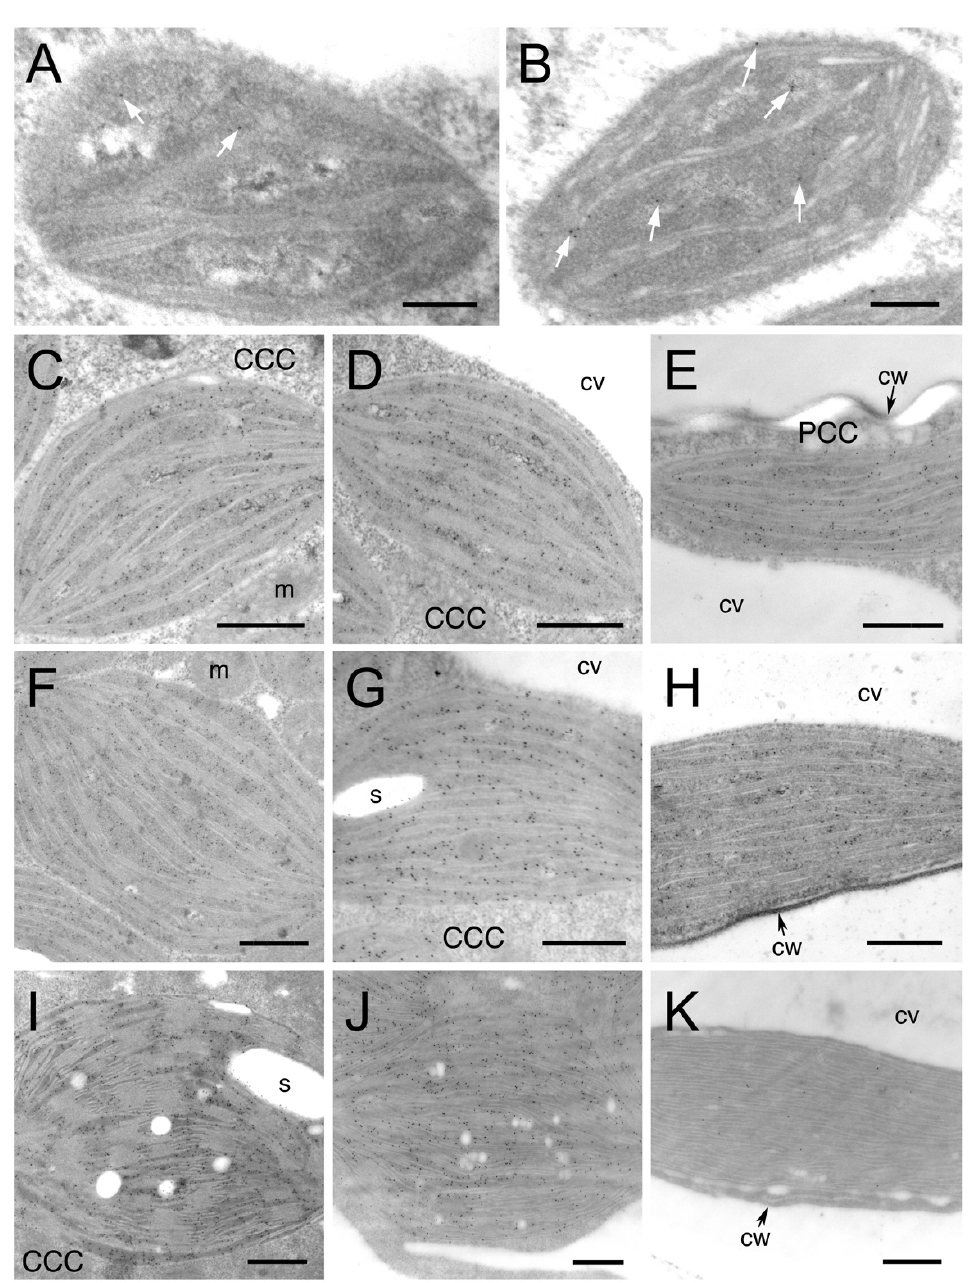
Figure 2. Immunolocalization of RbcL in chloroplasts in developing leaves of B. sinuspersici . Leaf cross-sections from various developmental stages were probed with RbcL antiserum and then with a gold-conjugated secondary antibody. Images are transmission electron micrographs of chloroplasts in ( A ) youngest, ( B ) young, ( C – E ) intermediate, ( F – H ) premature, and ( I – K ) mature leaves showing a specific reaction of the RbcL antibody. Starting from the intermediate stage, the CCC and PCC ( E , H , K ) are evident. Chloroplasts in the CCC were further divided into the inner layer of CCC (CCCI: C , F , I ) and the outer layer of CCC (CCCO: D , G , J ). White arrows indicate gold particles ( A , B ). RbcL, Rubisco large subunit; CCC, central cytoplasmic compartment; PCC, peripheral cytoplasmic compartment; s, starch; cv, central vacuole; cw, cell wall; m, mitochondria. Scale bars = 200 nm ( A , B ) or 500 nm ( C – K ).